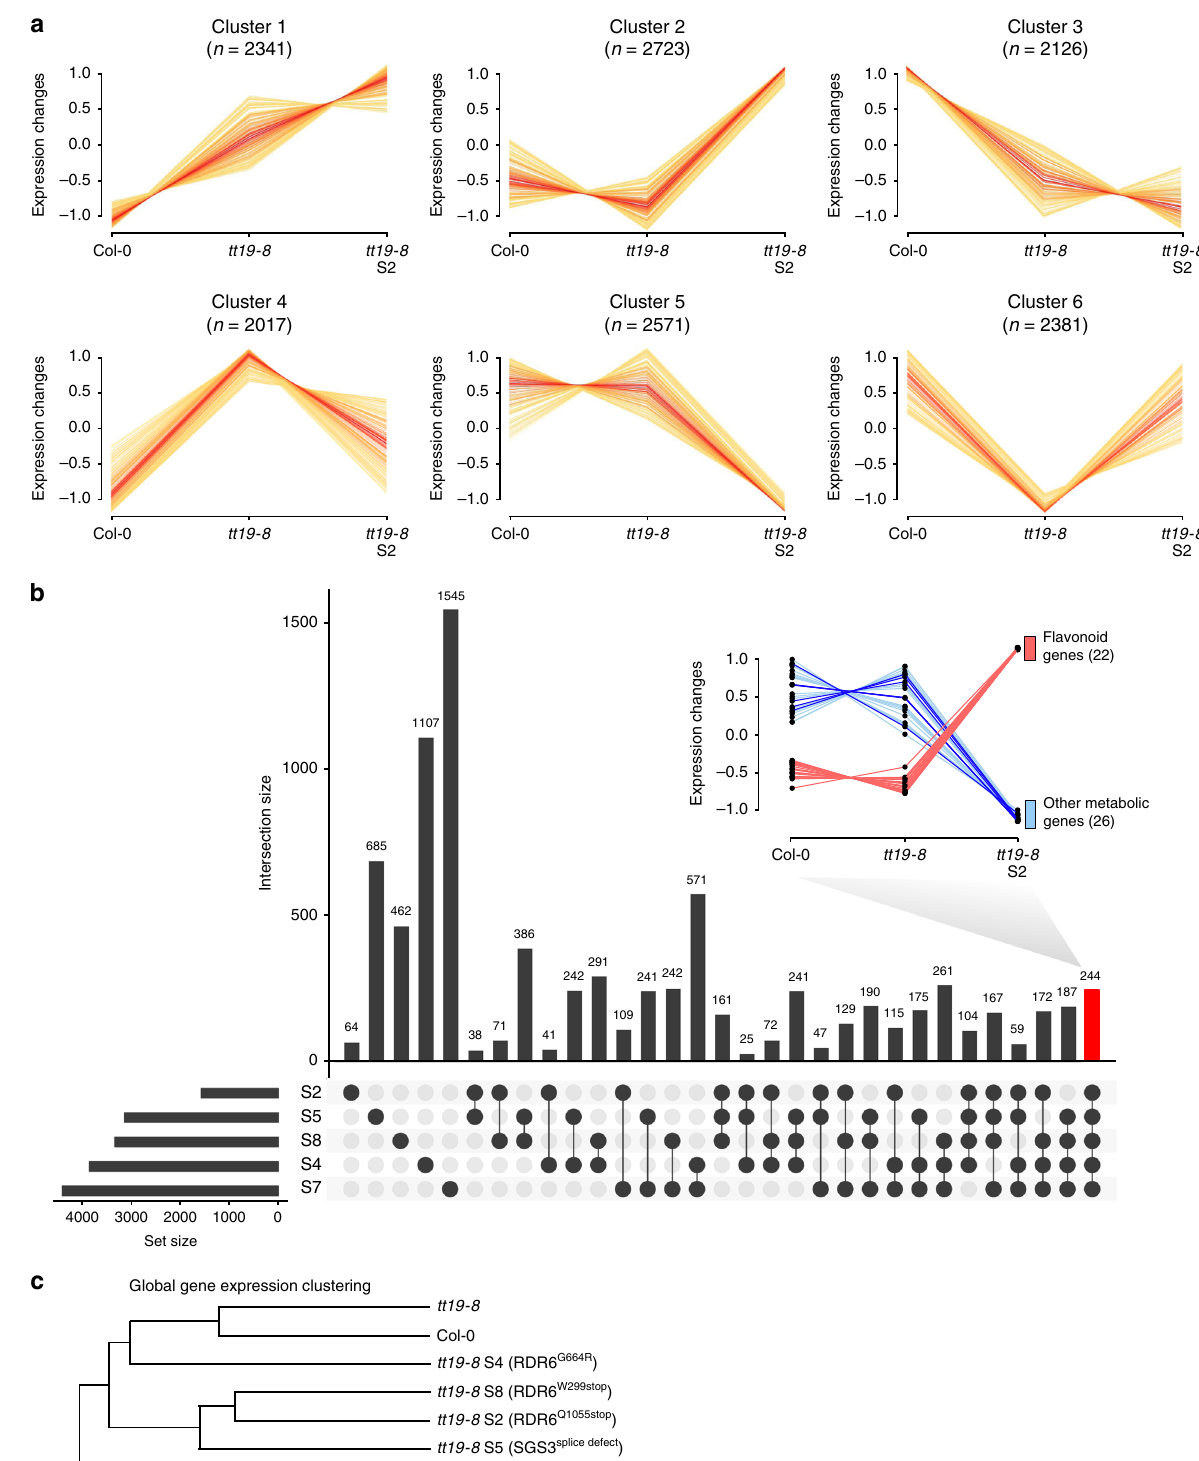
in clusters 1, 2, 3, and 5, Fig. 4a) exhibited different expression in tt19-8 S2 (strong suppressor), compared to tt19-8 or Col-0. Cluster 2 included late anthocyanin pathway genes that showed decreased mRNA accumulation in tt19-8 and early anthocyanin pathway genes (e.g., CHS and CHI ) that are also required for fl avonol accumulation (Fig. 3, Supplementary Data